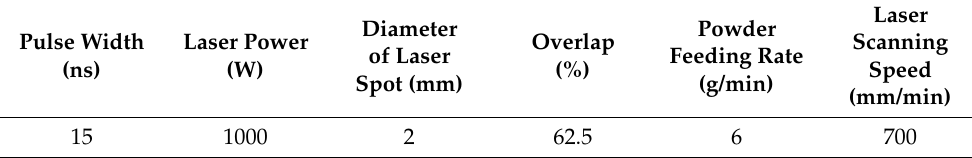
Table 2. Process parameters for the LCR process.